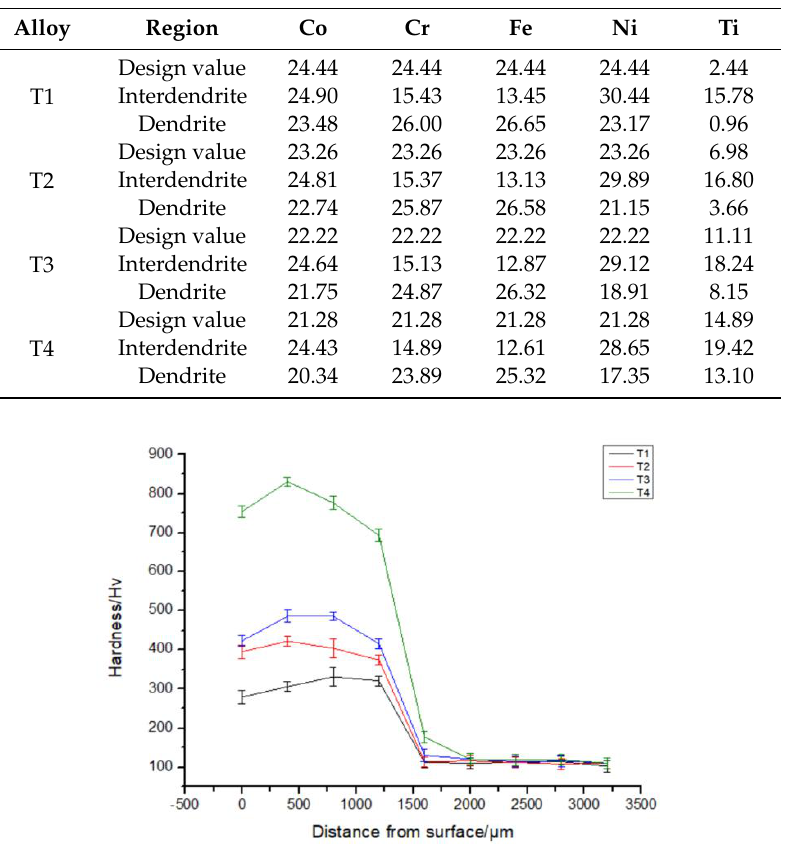
Table 2. ElementdistributioninthedifferentregionsofCoCrFeNiTi x LaserCladdingCoatings,wherex = 0.1, 0.3, 0.5, or 0.7, and are abbreviated as T1, T2, T3 or T4, respectively (at.%).